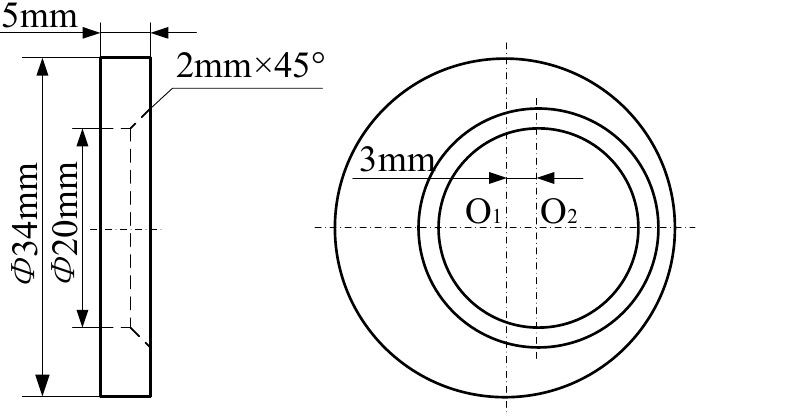
Figure 7. Eccentric wheel geometry.